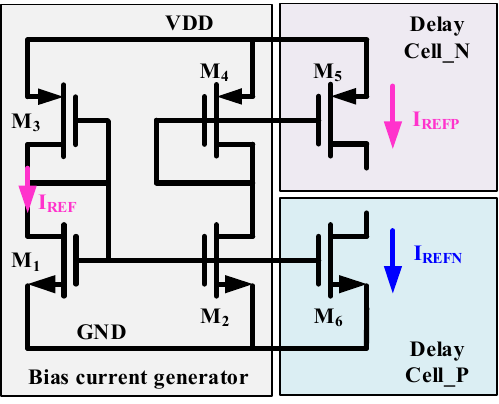
Figure 6. Bias current generator.